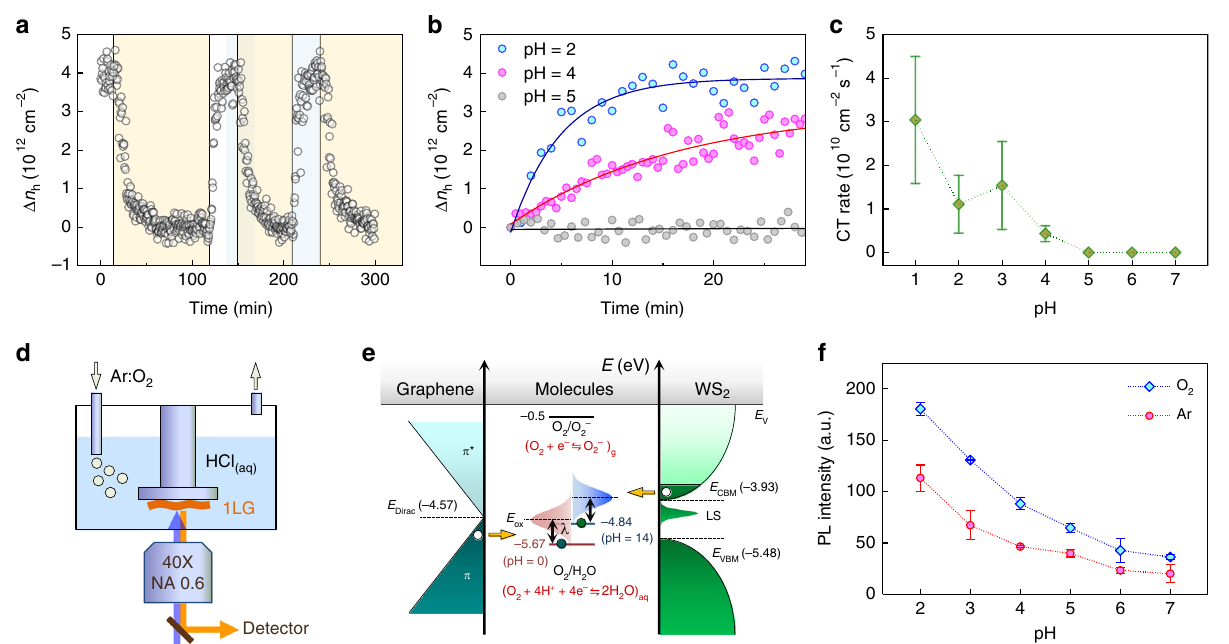
Fig. 4 pH-controlled charge transfer. a Time-lapse measurements of charge density in 1LG silica in HCl solution (pH = 2) through which Ar (yellow box) and O 2 (blue box) gases were sparged alternatively. The data near time zero (white box) were obtained with the HCl solution aerated. Δ n h was referenced to n fl ow. b pH-dependent kinetics of O = 2 (blue), 4 (magenta), and 5 (gray). The h for the Ar 2 -induced rise in charge density of 1LG silica in HCl solutions: pH solid lines are exponential fi ts to the data. c Initial charge transfer rate per unit area of 1LG silica in HCl solutions of varying pH. d Scheme of the optical liquid cell with a gas sparger combined to a micro-spectroscopy setup. e Energy-level diagram for redox-governed charge transfer from graphene and WS 2 to O 2 / H 2 O redox couples. Electron-accepting oxidized states are represented by Gaussian distributions displaced from E F,redox by a solvent reorganization energy ( λ ). The Fermi levels of electron donors are at E Dirac for graphene and near the conduction band minimum (CBM) for WS 2 . LS represents localized mid-gap states originating from defects. f Total PL intensity of 1LW silica modulated by O 2 dissolved in HCl solution of various pH. Error bars denote standard